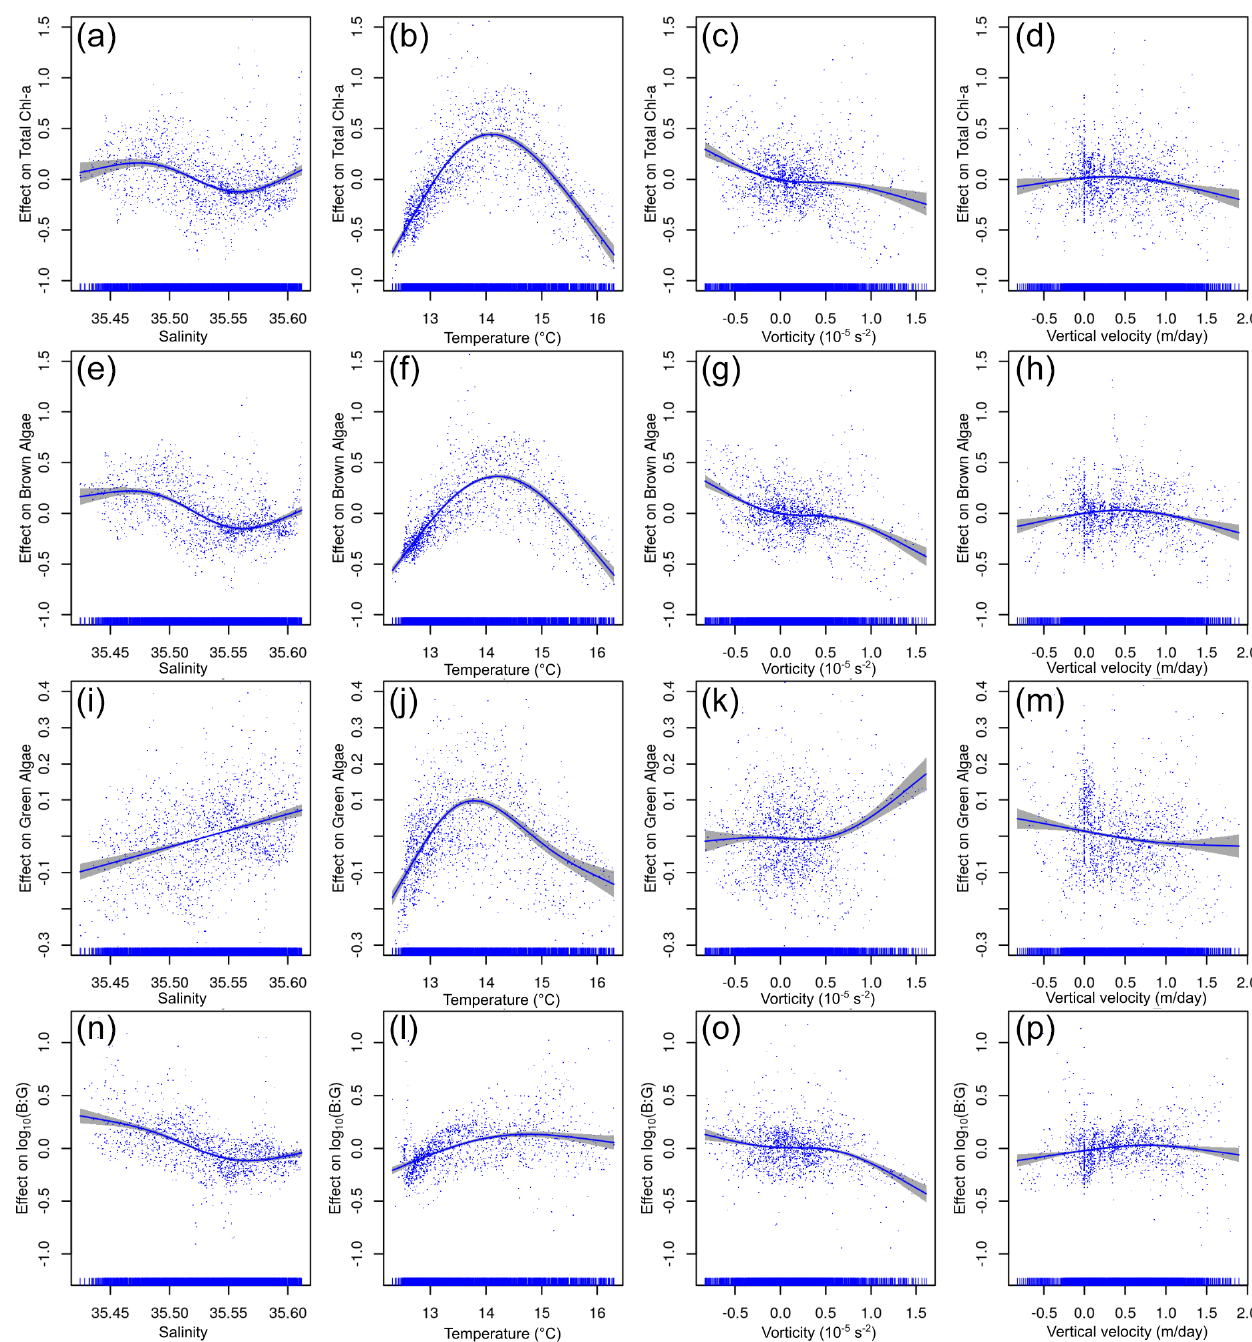
Figure 9. Relationship between environmental variables and chl a from the below the pycnocline (BPY) subset GAMs. The y axis indicates the additive effect that the term on the x axis has on the chl a . The following variables are shown (from top to bottom): total chl a , brown chl a , green chl a , and the brown : green (B : G) ratio. The shaded area represents the confidence interval of